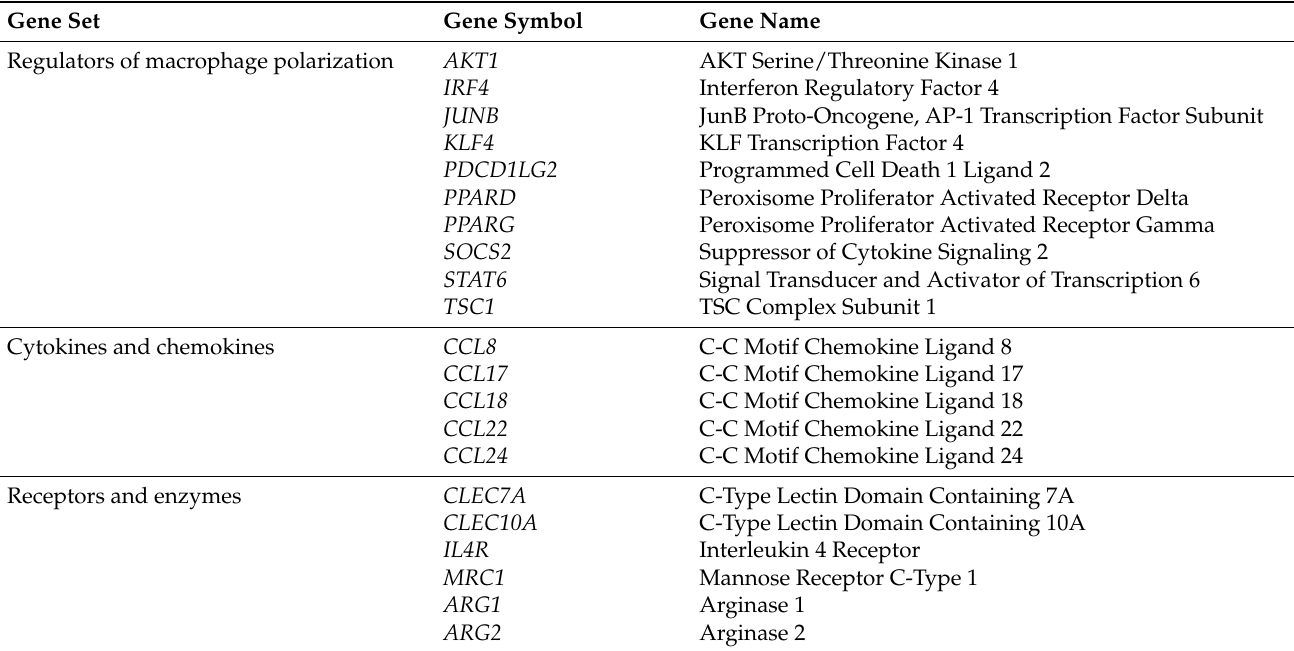
Table 2. M2 gene sets for differential gene expression